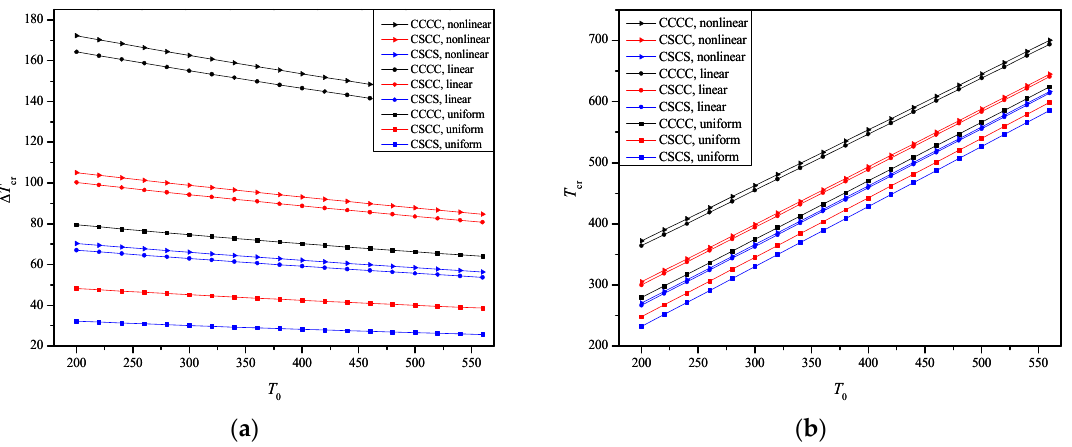
Figure 5. The relation between the critical buckling temperature Δ T cr and the length–width ratio a / b of type-I FGM, ceramic and metal rectangular thin plate ( a / h = 100, n = 2, T 0 = 300 K).